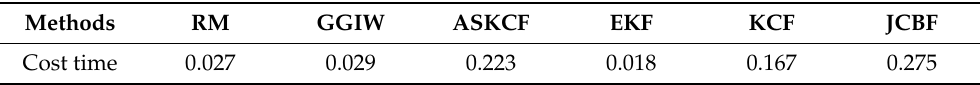
Table 4. Cost time per frame.